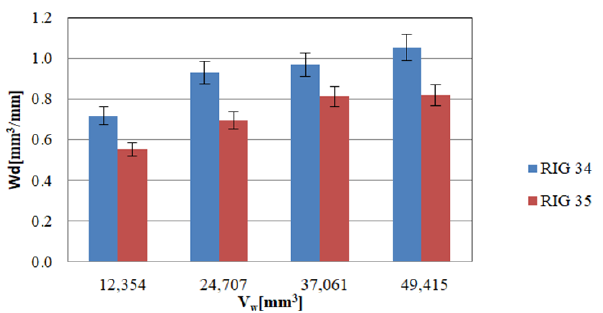
Figure 9. Dressing wear Figure 9 . Dressing wear parameters.